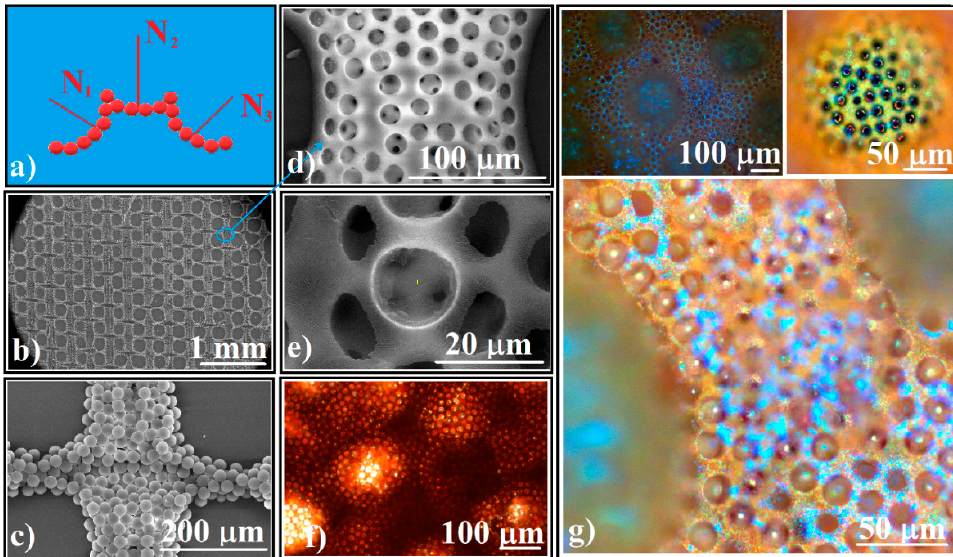
Figure 7. ( a ) Schematical of 3D high complexity superstructures which have an ordered concavity as structural unit; ( b , c ) SEM images of 20 µm polystyrene spheres hierarchical self-assembled as a grid; ( d ) close view SEM image of 3D silica spheres high complexity superstructure; ( e ) close view SEM image of 3D polystyrene inverse opal high complexity superstructure; ( f ) transmission optical microscopy image of 3D polystyrene inverse opal high complexity superstructure; ( g ) reflection optical microscopy images of 3D polystyrene inverse opal high complexity superstructure.